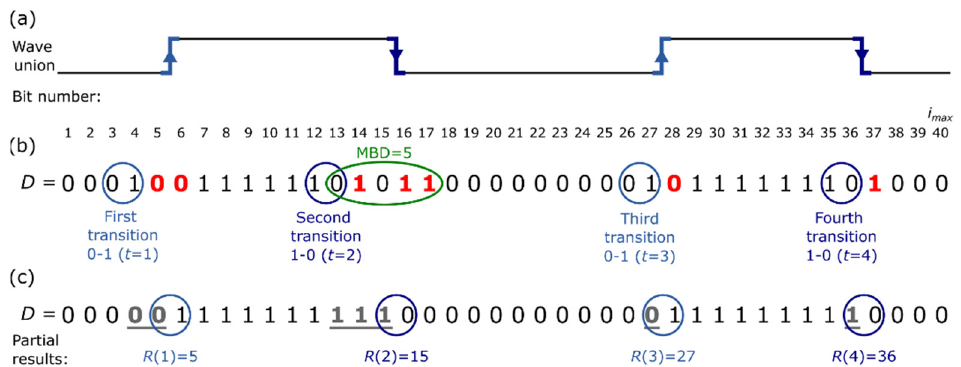
Figure 3. Data encoding problem: ( a ) wave union shape inside the TDL, ( b ) raw data latched in a register (bubble errors marked red), ( c ) data after bubble suppression (reordered bubbles marked grey and underlined).